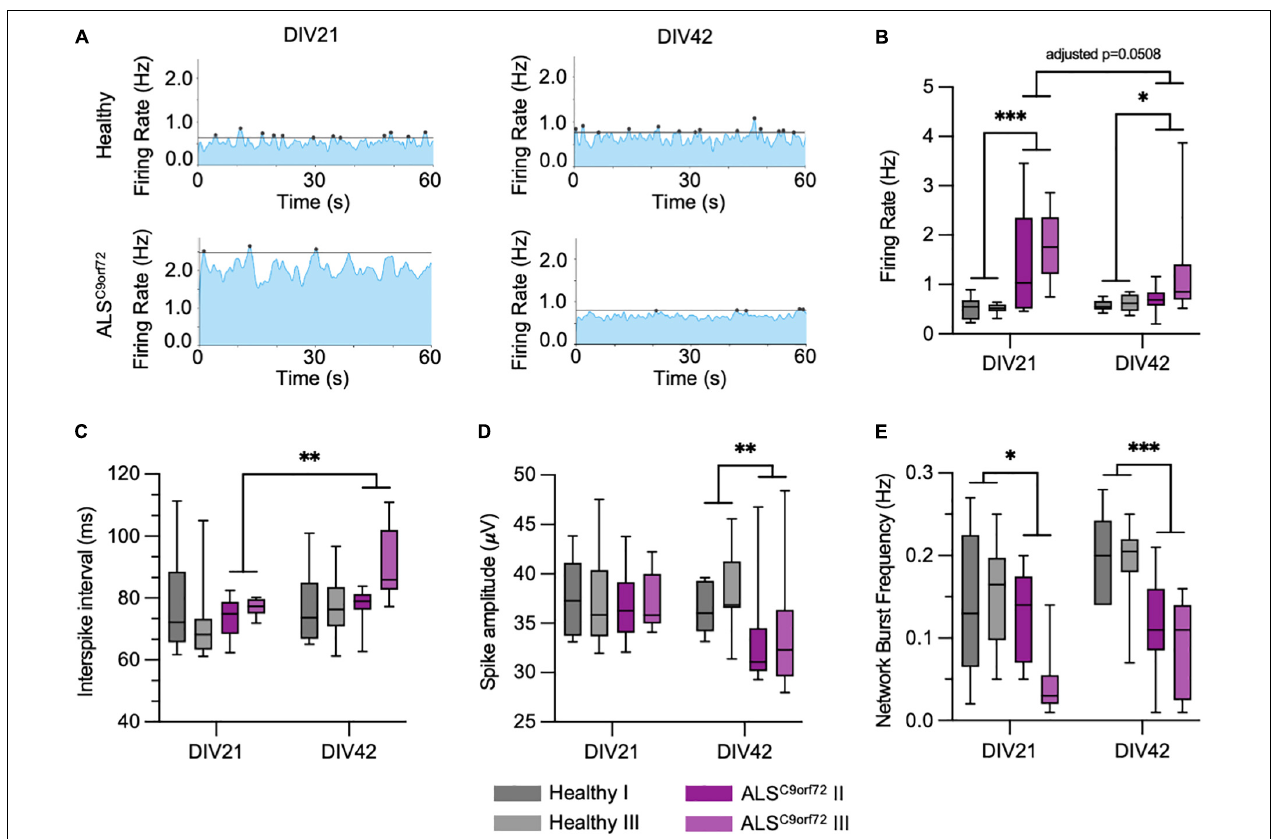
FIGURE 2 | ALS C9orf72 motor neurons display age-dependent alterations in activity and network properties. (A) Representative network activity plots of Healthy and ALS C9orf72 MN at DIV21 and DIV42 (lines indicate the network burst detection threshold). (B) ALS C9orf72 MN display an early hyperactivity compared to controls at DIV21. At the later time point, the firing rate of both ALS C9orf72 lines drops to values closer to Healthy ones, even though the two ALS C9orf72 show a close-to-significance difference in this firing property (firing rate at DIV42, ALS C9orf72 II vs. ALS C 9 orf 72 III: p = 0.074). (C) Within the ALS C9orf72 genotype, the interspike interval (ISI) during repetitive firing sequences significantly increases between the two time points. (D) ALS C9orf72 MN show a reduced spike amplitude at DIV42. (E) The network burst frequency is significantly lower in ALS C9orf72 than in Healthy MN at both time points. ∗ p < 0.05; ∗∗ p < 0.01; ∗∗∗ p <